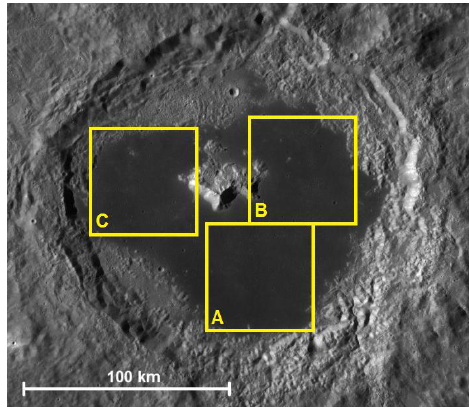
Figure 6. Test regions A, B and C in crater Tsiolkovsky overlaid on LROC WAC mosaic image (Speyerer et al., 2011). Method